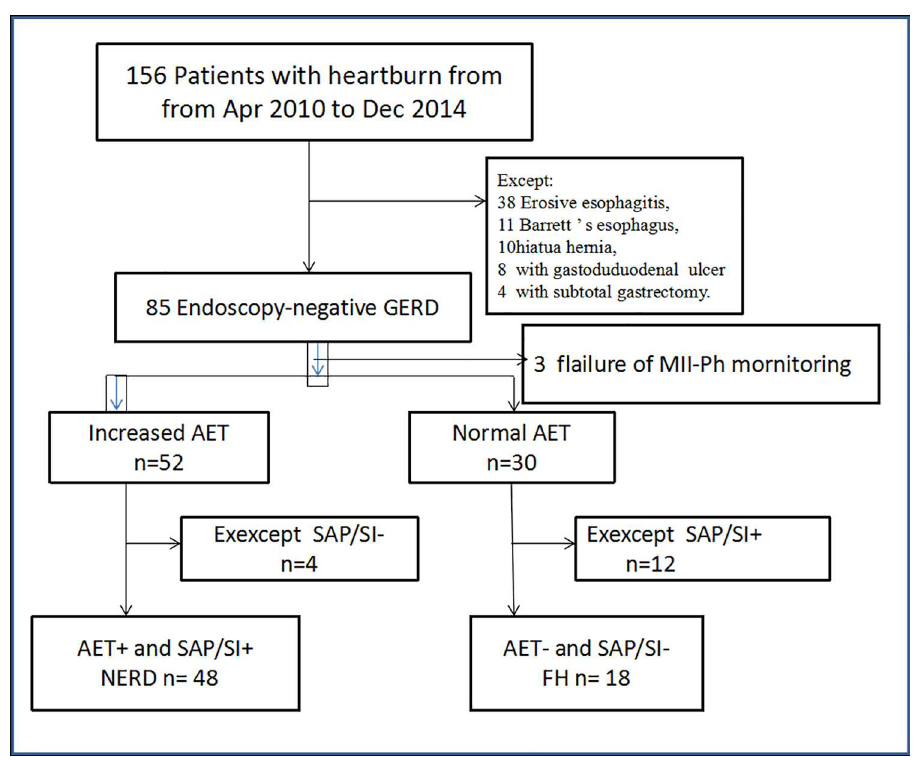
Fig 1. Study design and the disposition of